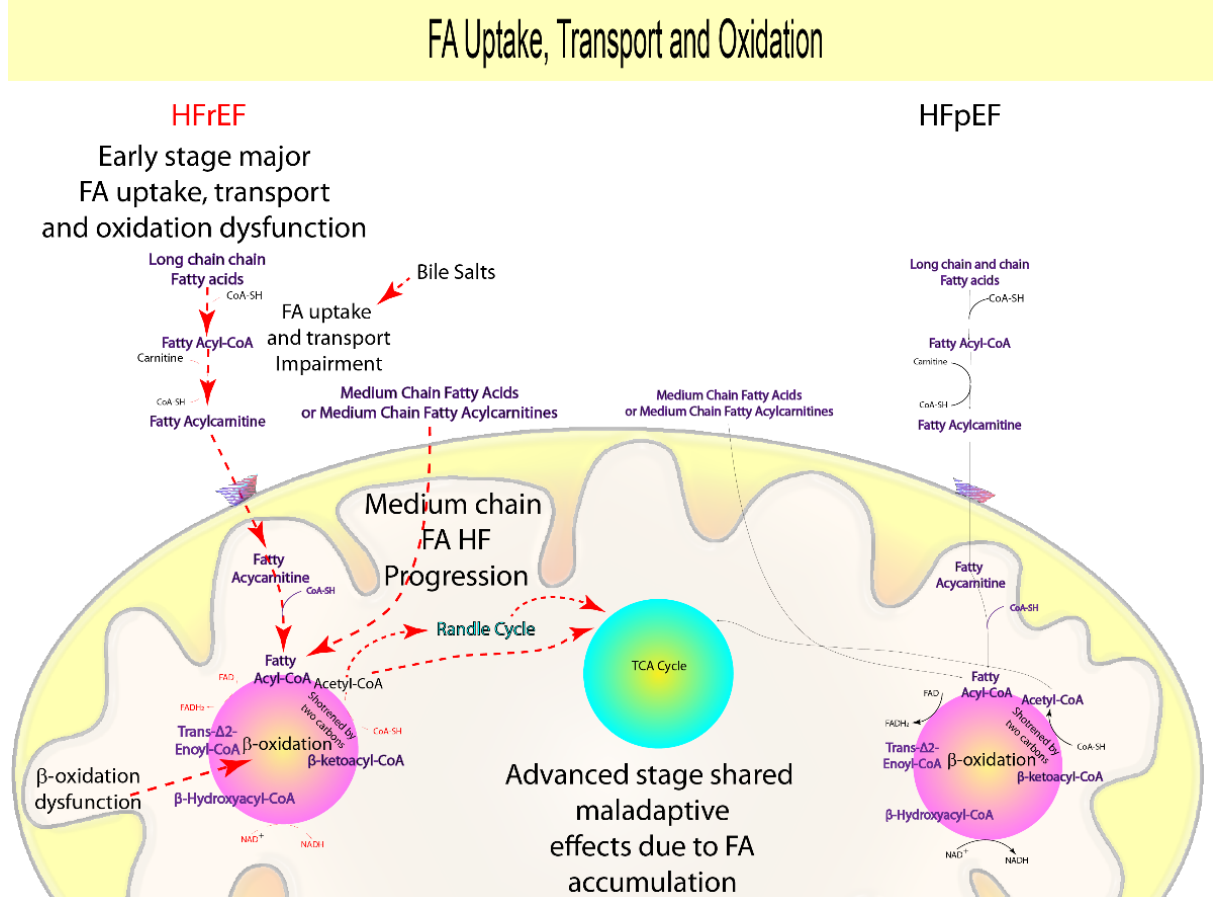
Figure 2. Suggested prognostic metabolites involved in FA metabolism. Increased plasmatic LCAC as a result of rapid FA metabolic impairment is an attractive indicator for diagnosing the early stages of HFrEF, as opposed to early-stage HFpEF, which has less impairment and a greater reliance. Furthermore, MCAC (i.e., octanoyl acid) may play a role in the progression of HFrEF from early to late stages, which is consistent with a neurohormonal and direct cardiac injury